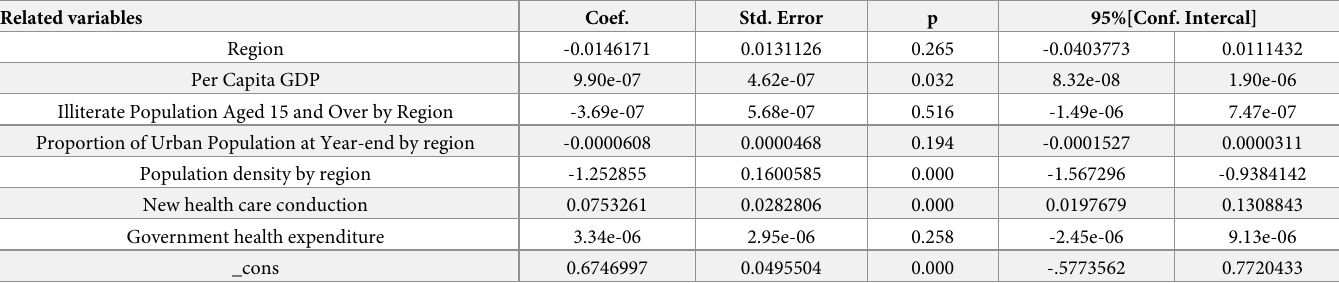
Table 4. The result of the Tobit